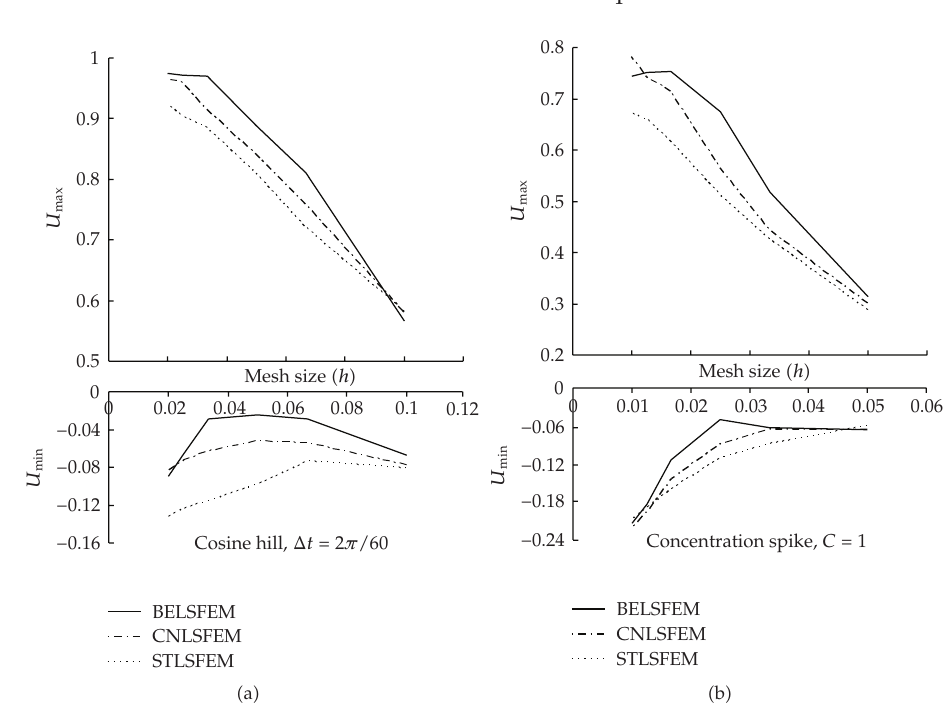
Figure 8: E ff ect of mesh size h on the performance of BELFEM and LSFEM.